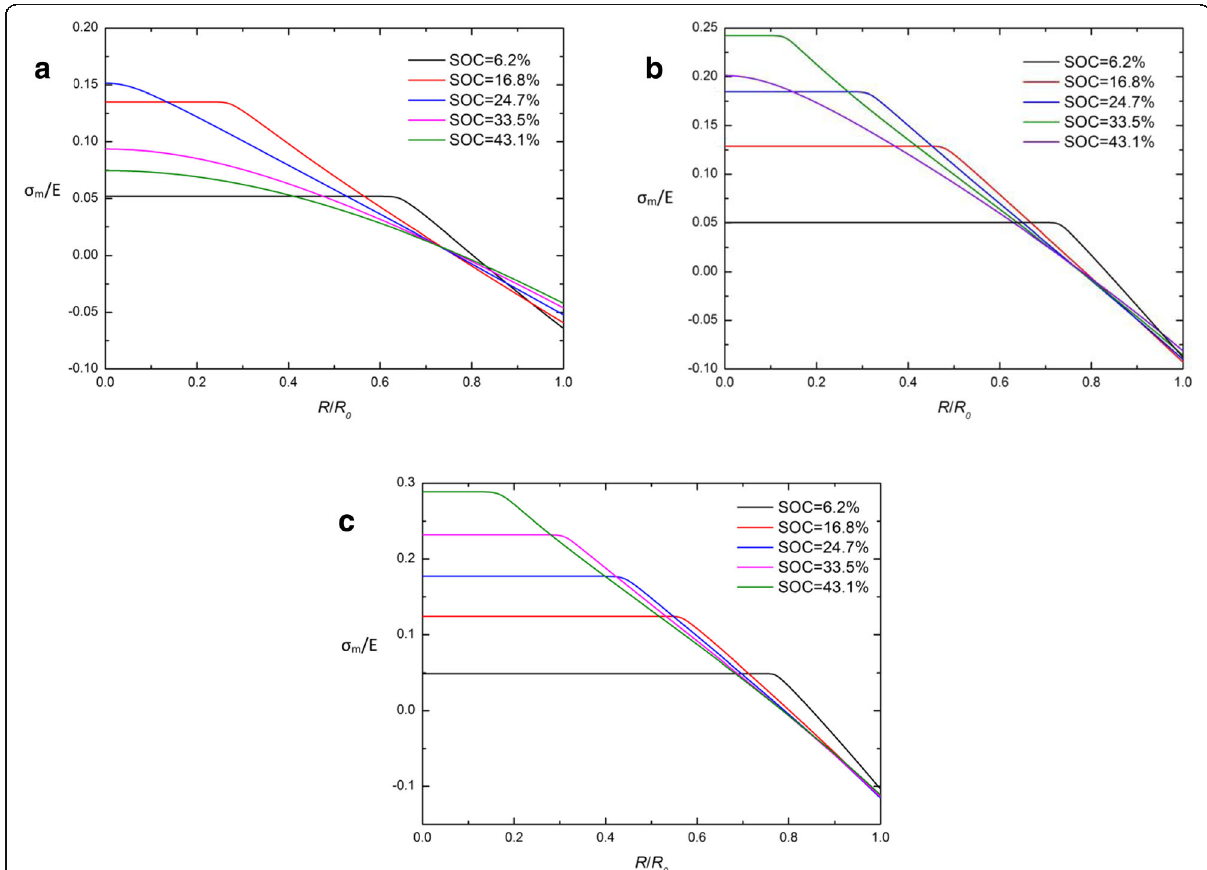
Fig. 5 Spatial distribution of σ m /E in a spherical Si nanoparticle electrode at different SOCs under galvanostatic operation with the traditional expression of chemical potential and ( a ) j = 0.5 j 0 , ( b ) j = j 0, and ( c ) j = 1.5 j